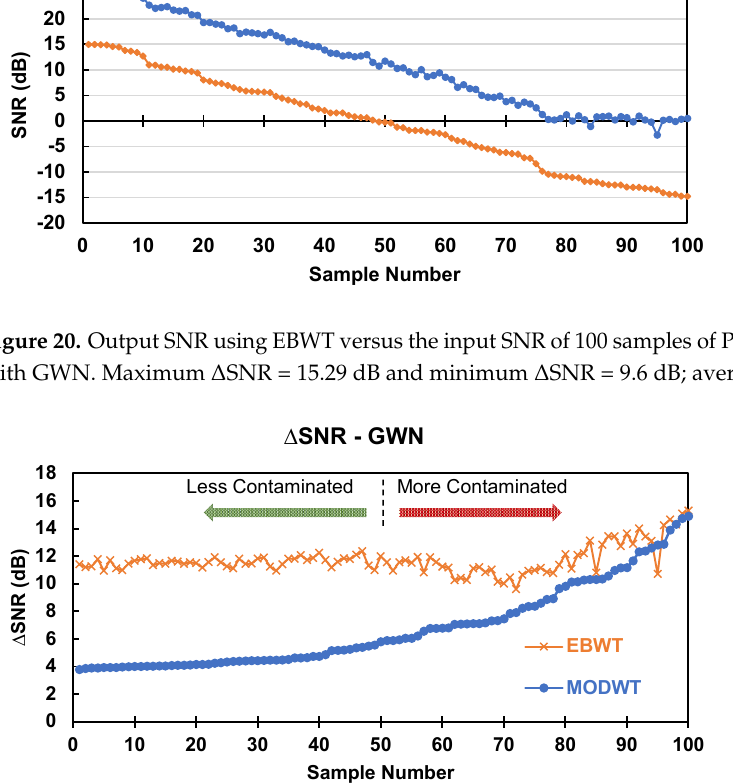
Figure 21. ∆ SNR for both MODWT and EBWT. In most cases, MODWT did not perform as well as EBWT with a lower average ∆ SNR of 6.81 dB, compared to 11.71 dB for EBWT. However, the difference in performance decreases as the signal becomes more noisy until they become